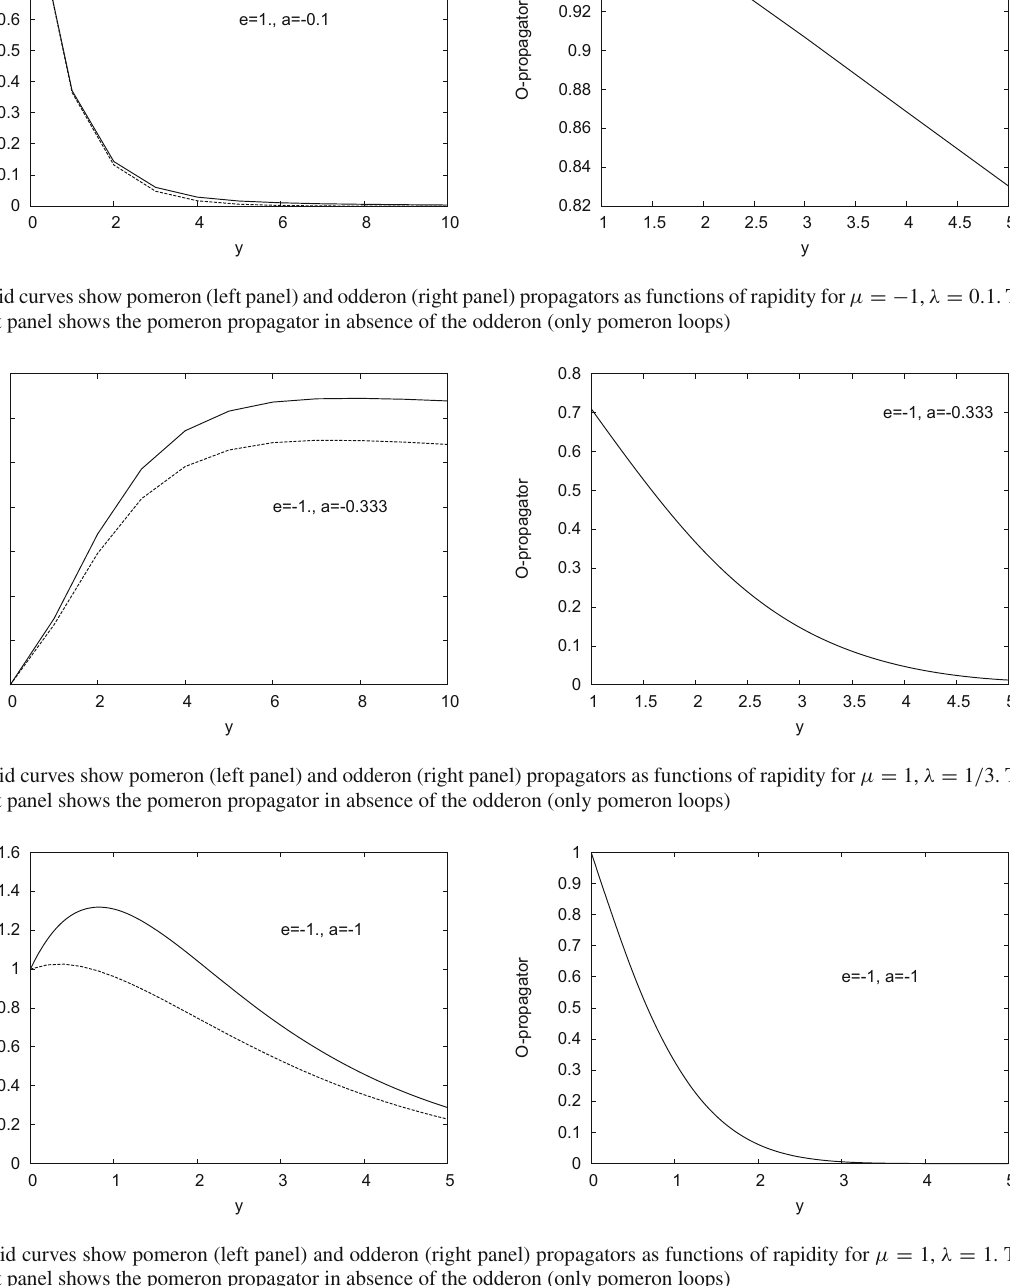
growth of rapidity. At large values of λ the effect of odderon loops starts at quite small y and becomes very strong; see Figs. 8, 9 and 10. In all cases at large enough y the pomeron propagator goes to